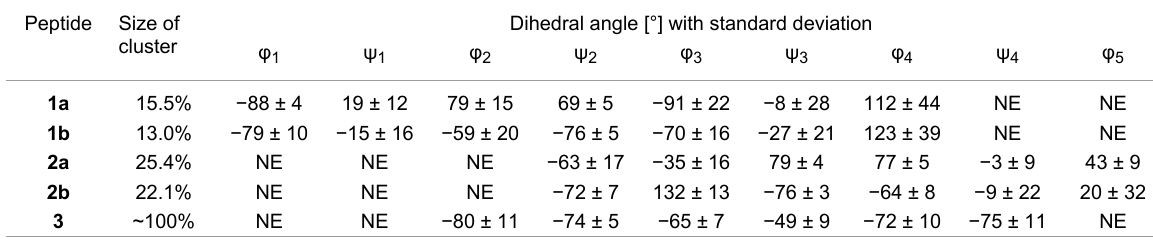
Table 3: Average values of dihedral angles [°] obtained on base of XPLOR-NIH calculations. Peptide Size of cluster